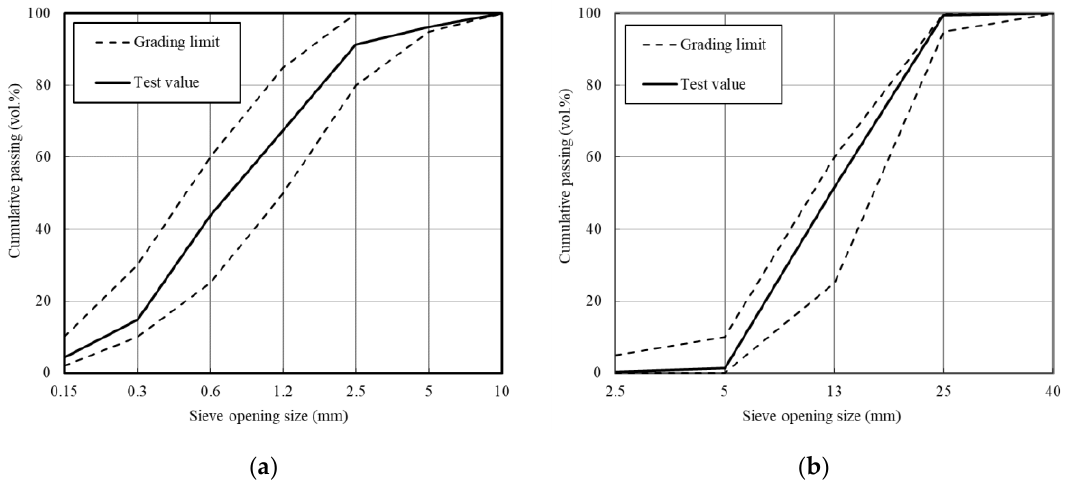
Figure 1. Gradation sieve analysis test result for the aggregates: ( a ) Fine aggregates and ( b ) coarse aggregates.